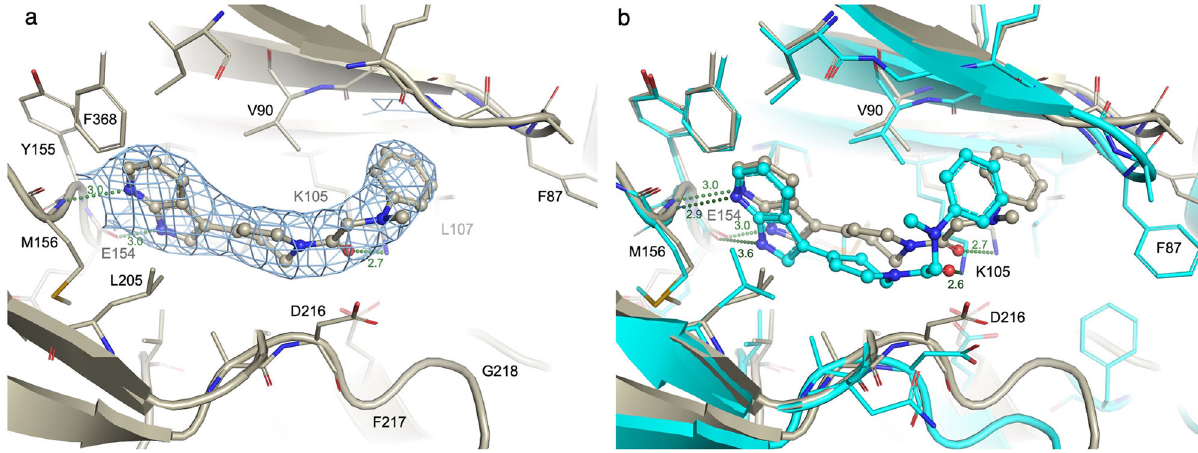
Fig. 5 | Comparison of the X-ray structure of compound 22 with its docked pose. a X-ray structure: the re fi ned 2Fo-Fc electron density is depicted at 1 sigma